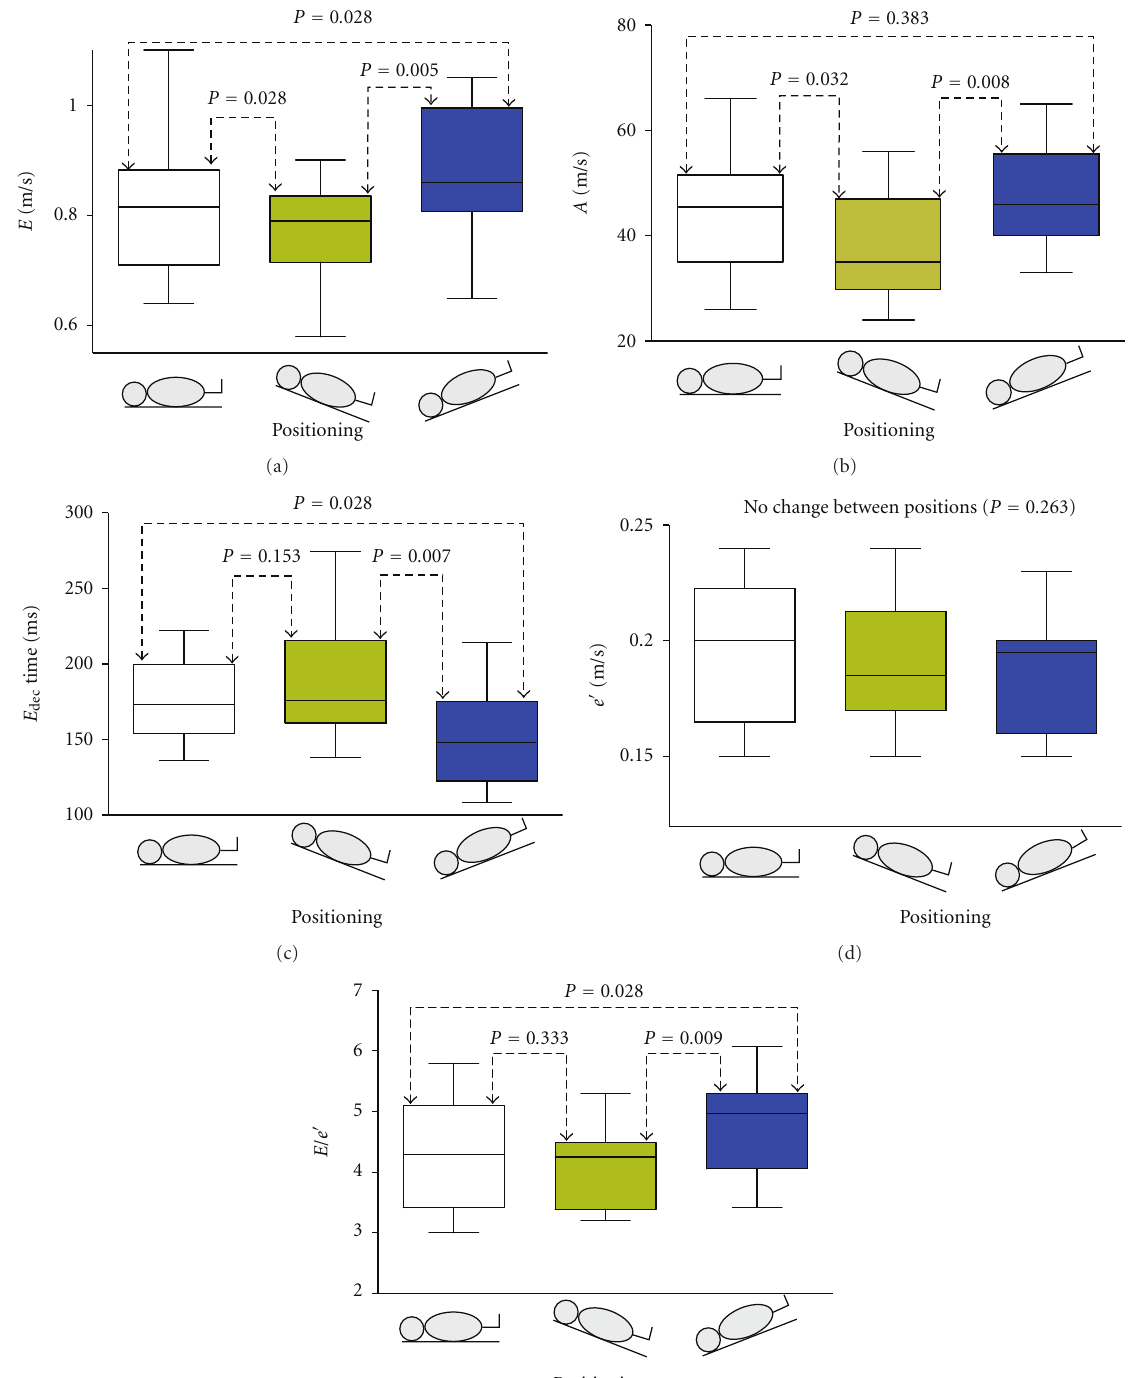
Figure 2: E ff ects of on- and o ff -loading during spontaneous respiration. Echocardiographic indices of diastolic function with subjects placed in varying positions during spontaneous respiration. e (cid:2) : peak early diastolic velocity of the lateral mitral annulus. E : peak early transmitral flow. A : peak atrial transmitral flow. E dec : deceleration time of E . Data are presented as median, interquartile range (box) and range (whiskers). Graphs show independency of e (cid:2) to preload, whereas E , E dec , A , and E/e (cid:2) vary according to